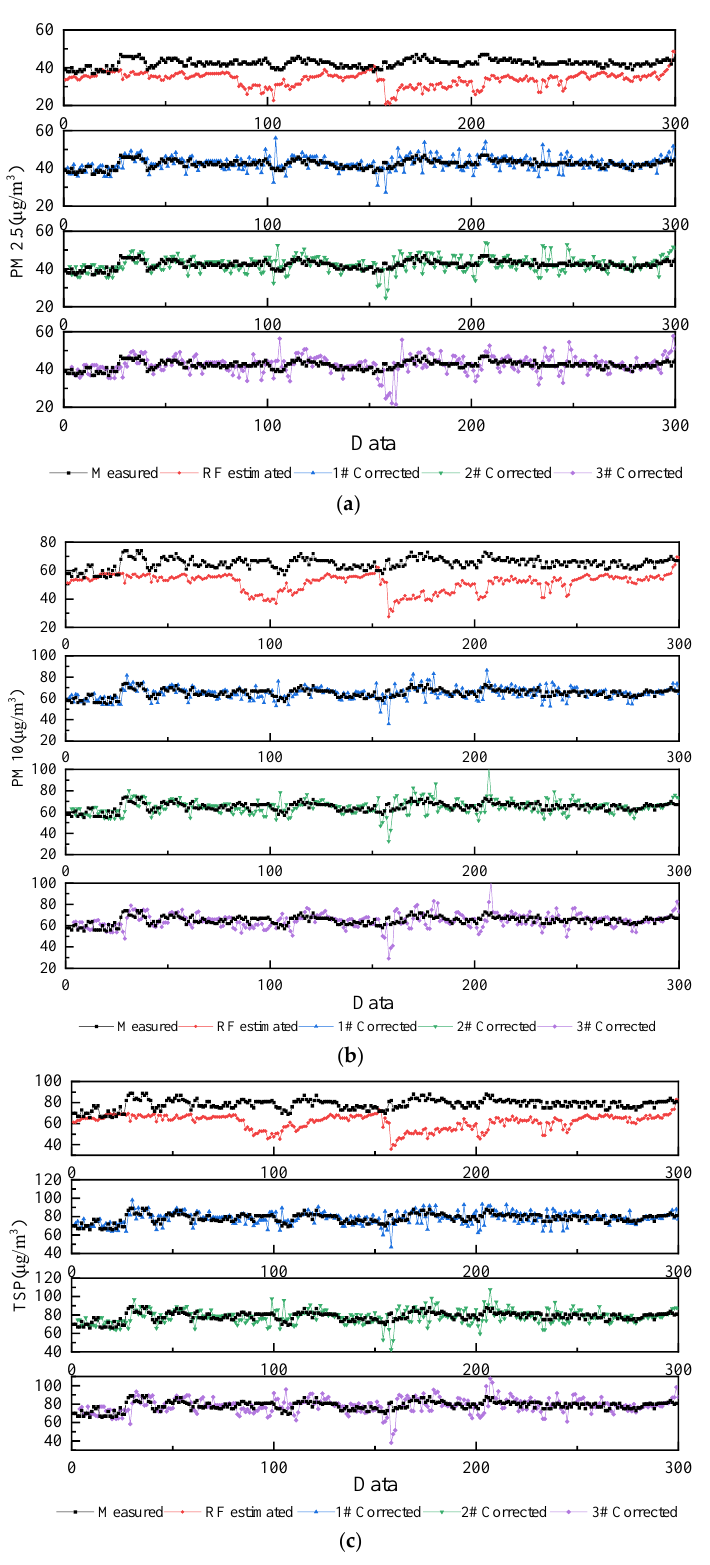
Figure 6. Comparison of curves before and after correction: ( a ) comparison curve of PM2.5; ( b ) comparison curve of PM10; ( c ) comparison curve of TSP.